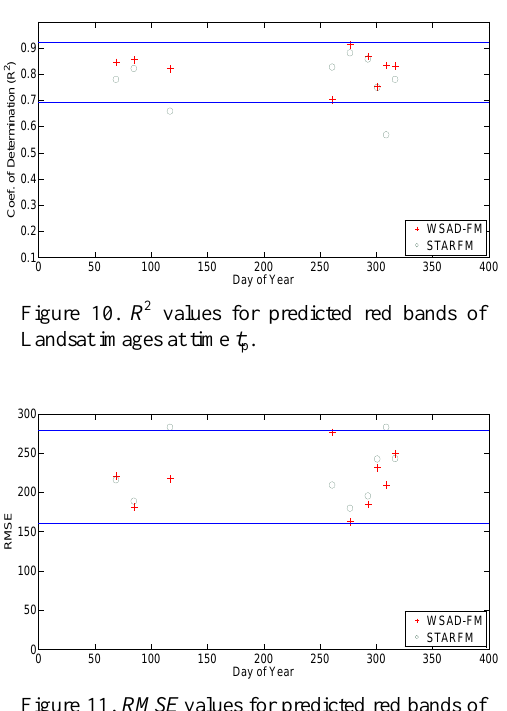
Figure 11. RMSE values for predicted red bands of Landsat images at time t p .